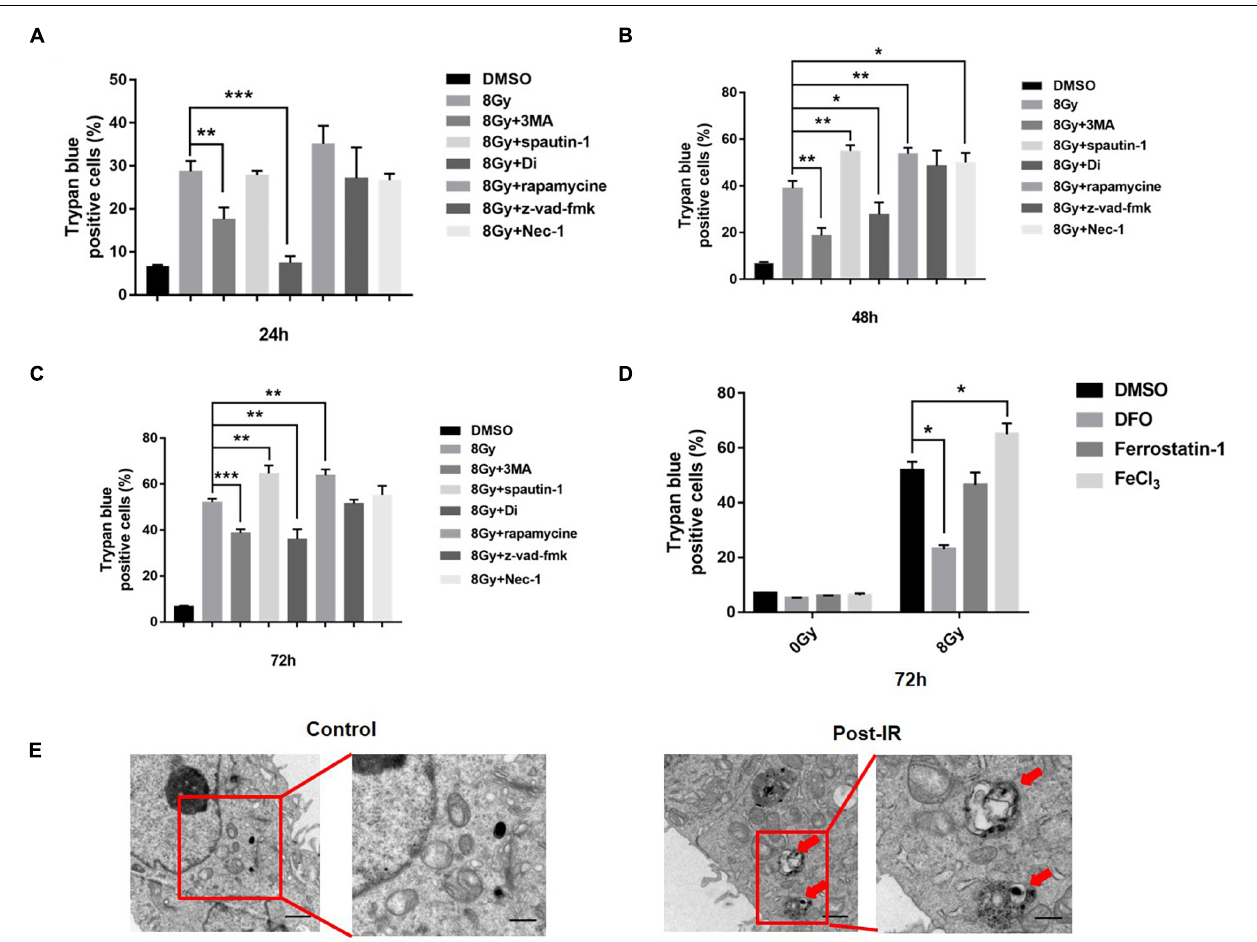
FIGURE 1 | Radiation induced cell death in MDA-MB-231 breast cancer cells. MDA-MB-231 were pretreated with different inhibitors of cell death, i.e., 3MA (2 mM), spautin-1 (3 µ M), rapamycin (5 nM), z-VAD-fmk (10 µ M), Necrostain-1 (10 µ M), Digitoxigenin (Di, 5 µ M) and cell deaths were quantified at 24, 48, 72 h after radiation (A–C) . Cells were pretreated with FeCl3 (30 µ M, pretreated for 3 h), DFO (0.1 mM), Ferrostain-1 (5 µ m) for 1 h, cell death was quantified at 48 h after 8 Gy radiation (D) . Electron microscopy analysis of autophagosome in the MDA-MB-231 cells was made after radiation treatment. Red arrow pointed to autophagosomes (E) . These results were representative of three independent experiments and expressed as means ± SD. P -values were calculated using repeated measure ANOVA with P < 0.05 being considered as statistical significance, * P < 0.05, ** P < 0.01, and *** P < 0.001.